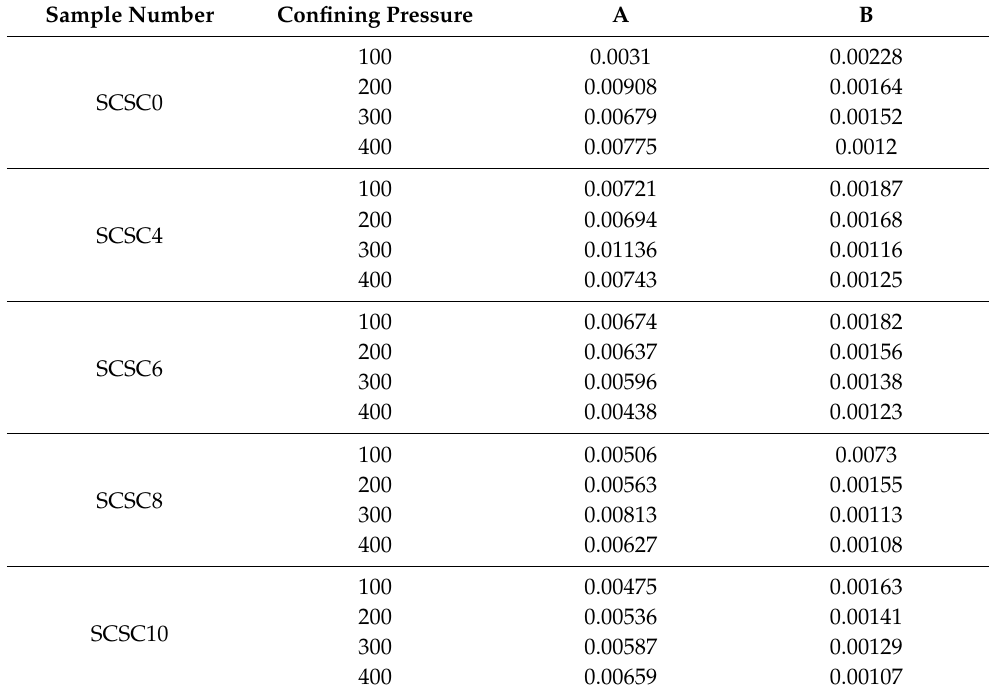
Table 5. Fitting parameters of Duncan–Chang